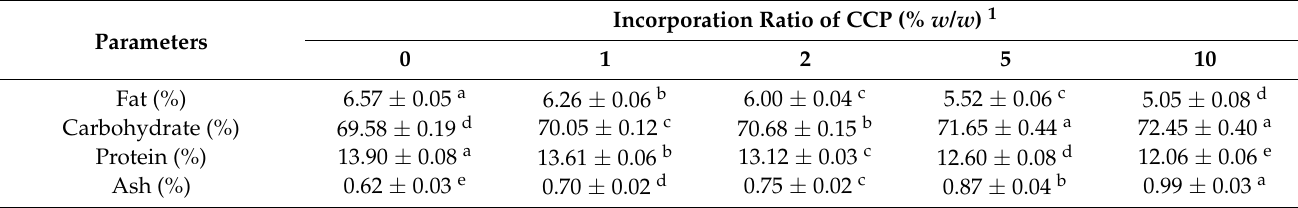
Table 2. Compositional profiles of experimental bread